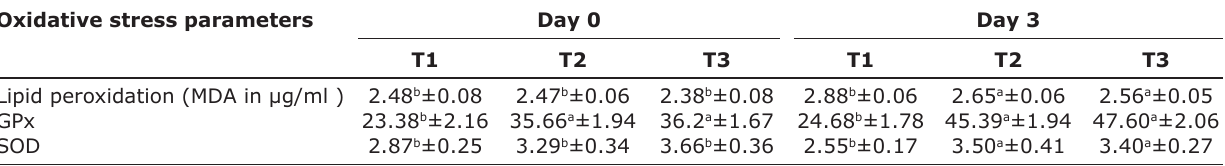
Table-2: Level of oxidative stress parameters (mean±SE) in spermatozoa incubated with antioxidants up to 72 h of incubation at 4°C. Oxidative stress